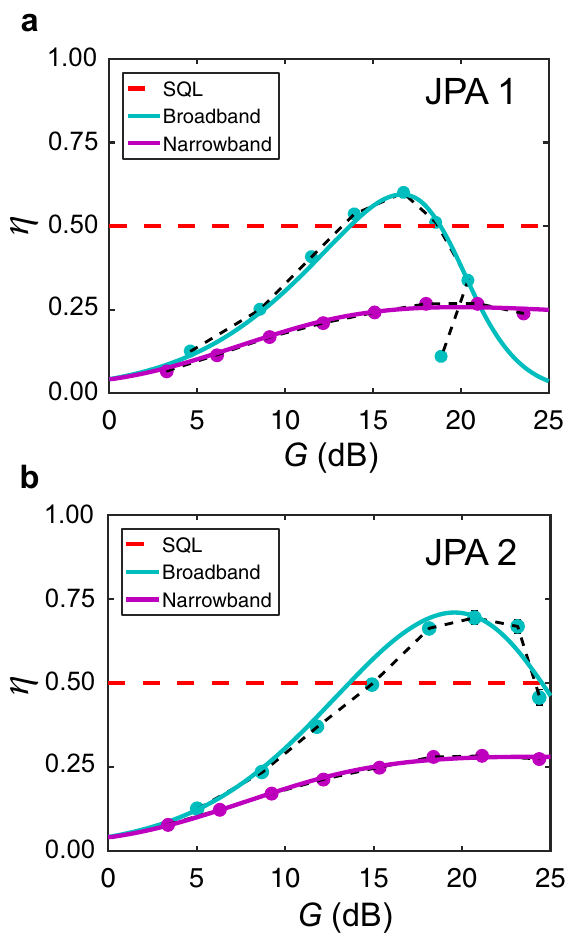
Fig. 4 Quantum ef fi ciency for nondegenerate broadband and narrowband ampli fi cation. Experimental quantum ef fi ciency of the fl ux-driven JPAs for broadband (cyan dots) and narrowband (purple dots) input signals. Panel a shows the data for JPA 1 and panel b the data for JPA 2. The red dashed line represents the SQL. The gain dependence of the quantum ef fi ciencies for the narrowband and broadband cases is fi tted using Eq.